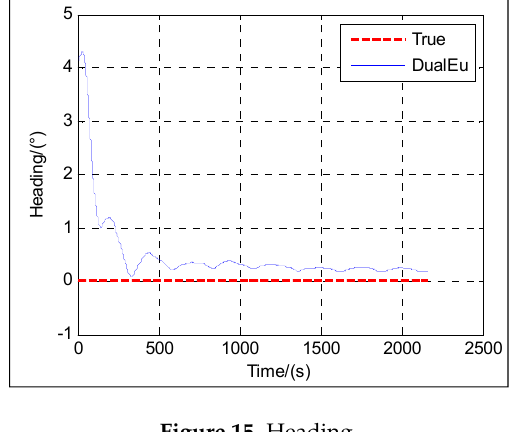
Figure 15. Heading. Figure 15. Heading.